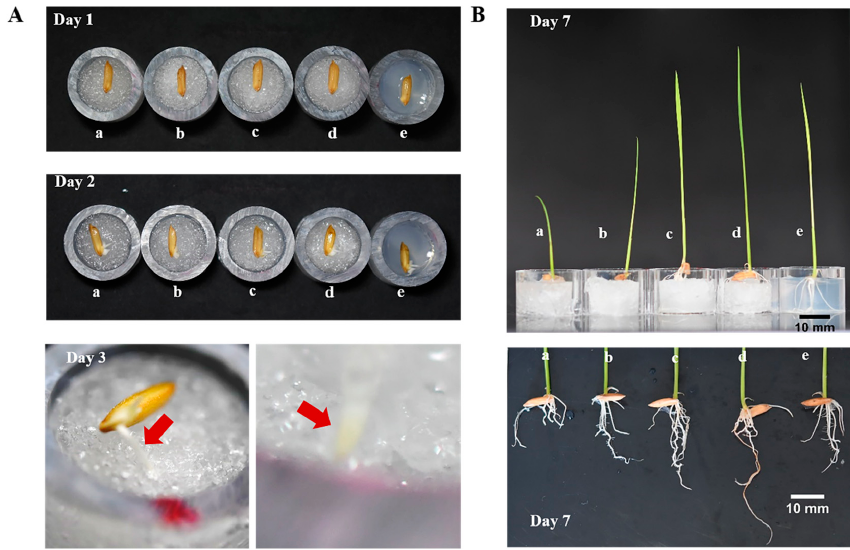
Figure 5. The growth of O. sativa on porous PDMS sponge. ( A ) Changes of seeds during the first 3 days of cultivation; ( B ) shoot and root development after 7 days of cultivation. ( a – d ) denote PDMS sponges prepared from a PDMS:CAM ratio of 1:1, 1:2, 1:3, and 1:4; ( e ) denotes 0.1% agar base.